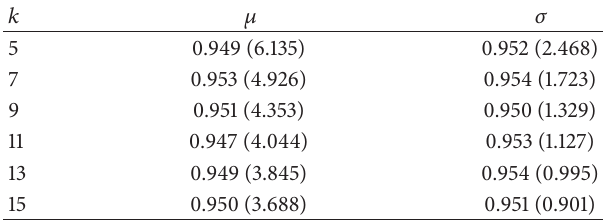
Table 1: CPs (ALs) of exact 95 % CIs for 𝜇 and 𝜎 .